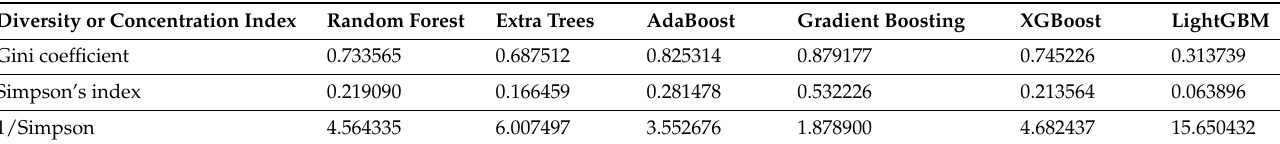
Table 3. Indexes of diversity and concentration for machine learning models’ feature importances.